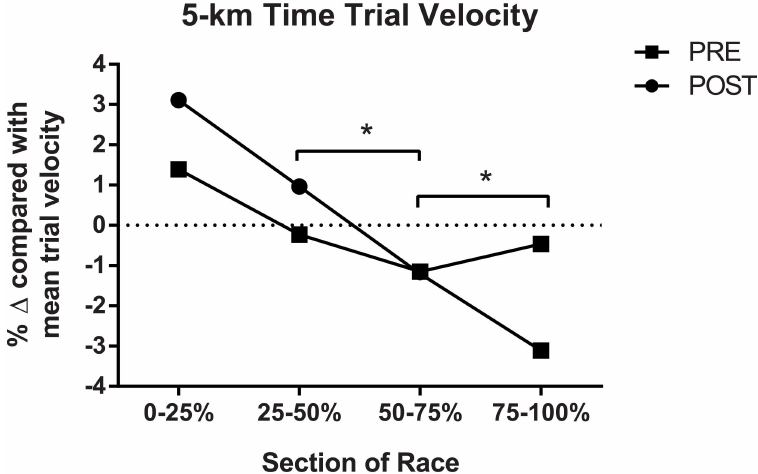
Fig 3. On-water rowing performance via 5 km time trial between PRE and POST. Mean boat velocity for each trial was calculated, with each split (0–25%, 25–50%, 50–75%,75–100% of race) assessedfor percent changecomparedwith the mean. Where a significant interaction betweentime points is observed, * indicates p < 0.05.